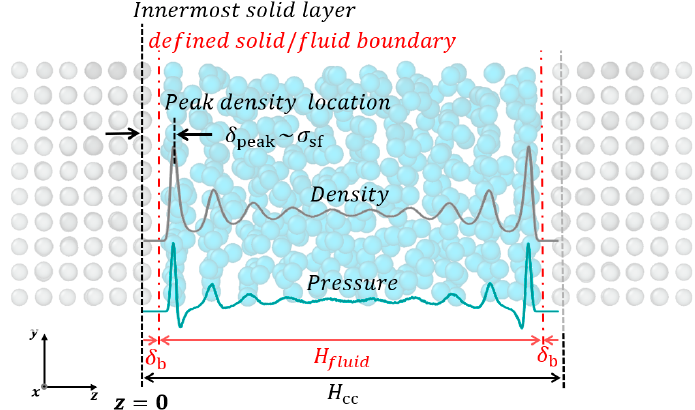
Figure 3. The density and pressure profiles of nano-confinement. A variable δ b is the distance between the innermost solid layer and the defined solid / fluid boundary. The channel height based on the defined boundary is H fluid ≡ H cc − 2 δ b .